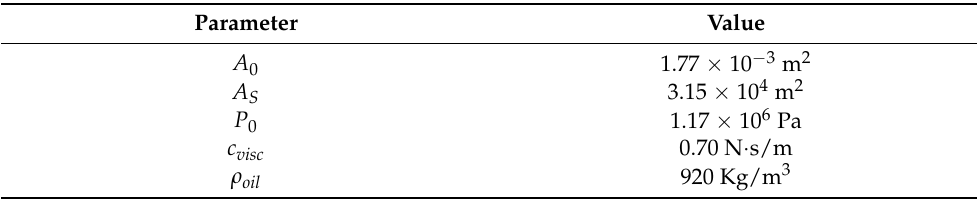
Table A3. Shock absorber main characteristics.